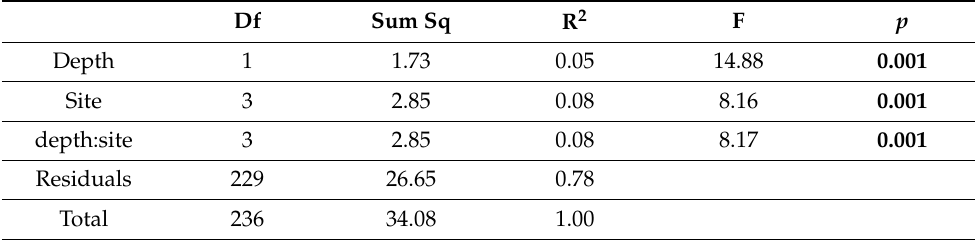
Table 4. Permutational multivariate analysis of variance (PERMANOVA, 999 permutations, based on a Bray–Curtis dissimilarity matrix) for the percent cover of benthic species. p -values < 0.05 highlighted in